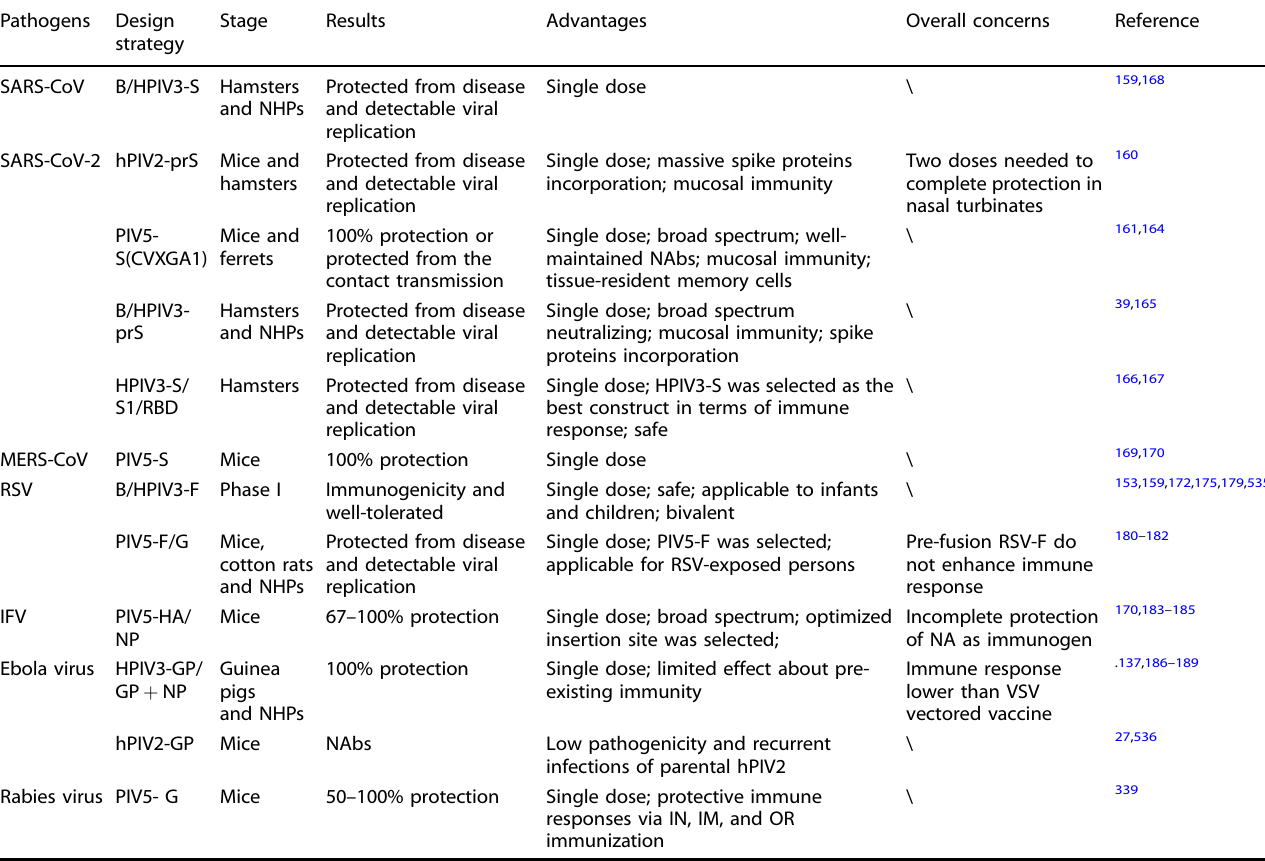
Table 4. Vaccines based on parain fl uenza virus vector Pathogens Design Stage Results Advantages strategy